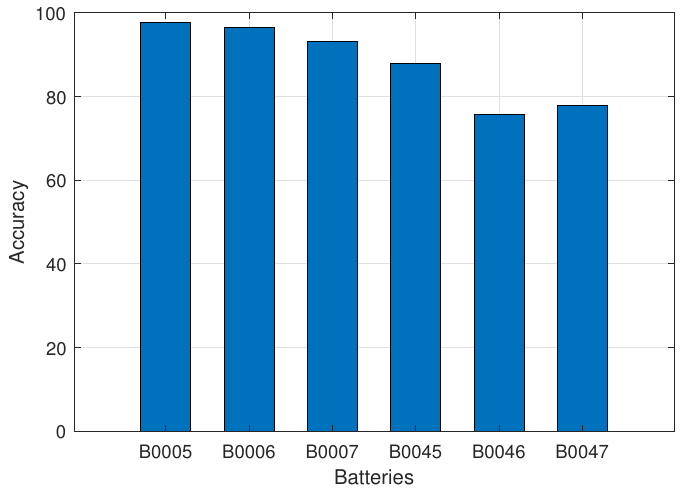
Figure 12. Accuracy results of training versus testing dataset of